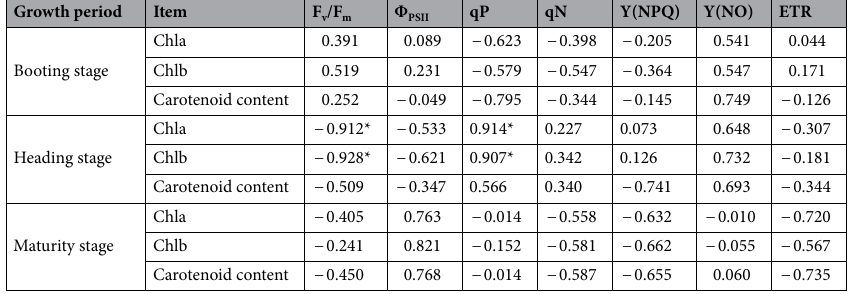
Table 2. Relationship between photosynthetic pigments and fluorescence parameters in rice leaves. Note Chla, chlorophyll a; Chlb, chlorophyll b.